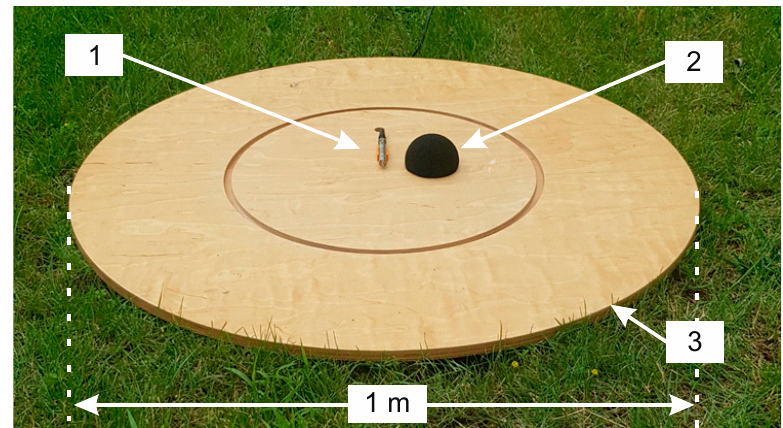
Figure 4. View of measuring setup, where: 1—GRAS 46AZ 26CI measuring microphone z with preamplifier located in a special holder; 2—external windscreen and 3—reflecting board.